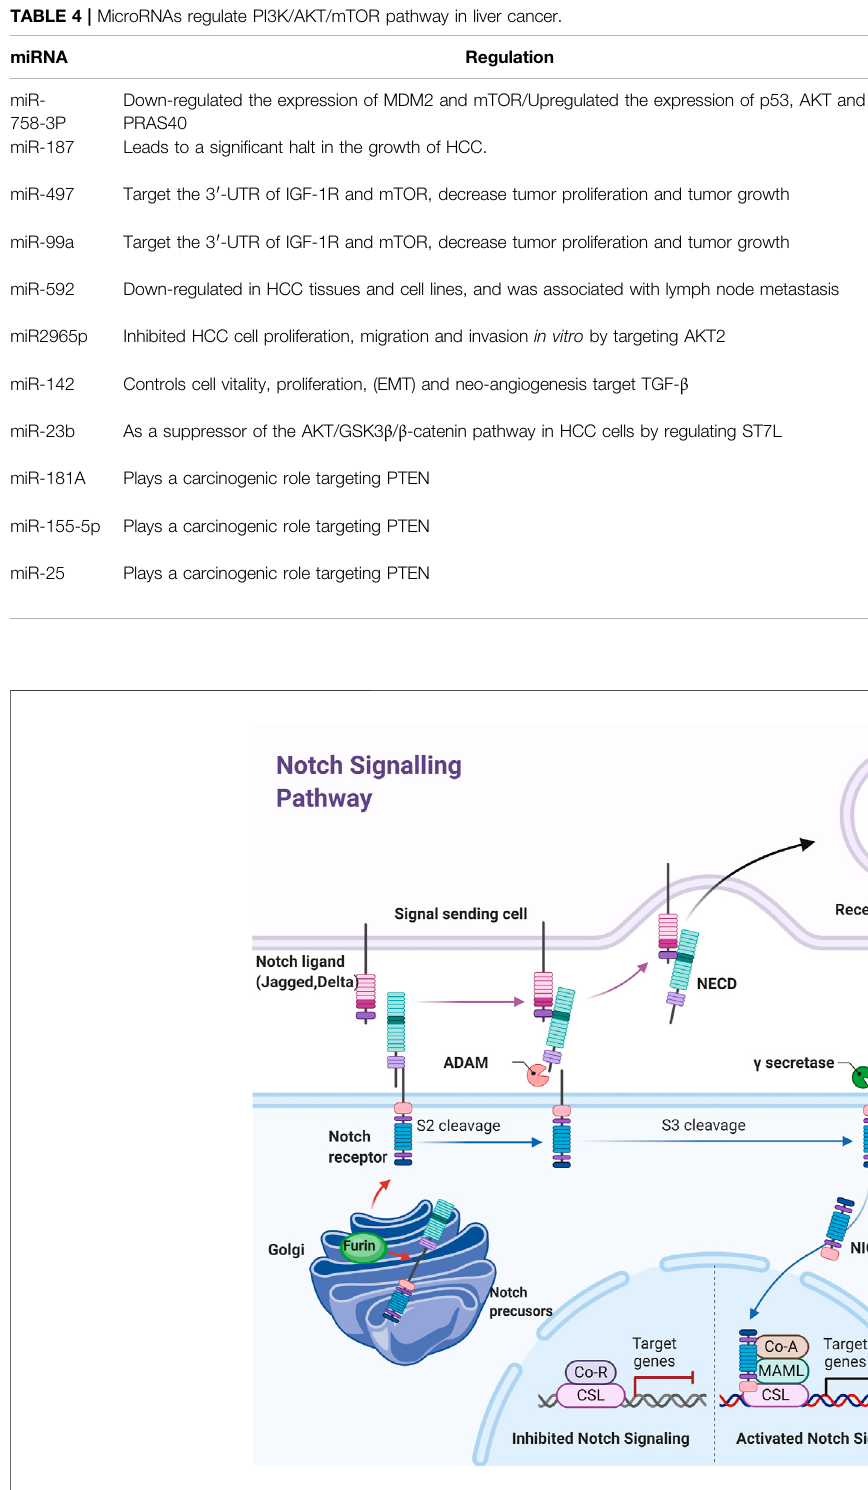
FIGURE 3 | Schematic diagram of the Notch pathway. The Notched mono-precursors are furin-cut in Golgi bodies to form mature Notched receptors and transferred to the plasma membrane. The Notch is activated when Notch ligands on adjacent cells combined with them, leading to second and third cut by ADAM and γ -secretes, releasing Notch intracellular domain NICD, which is transferred into the nucleus and combined with CSL to initiate downstream gene expression.